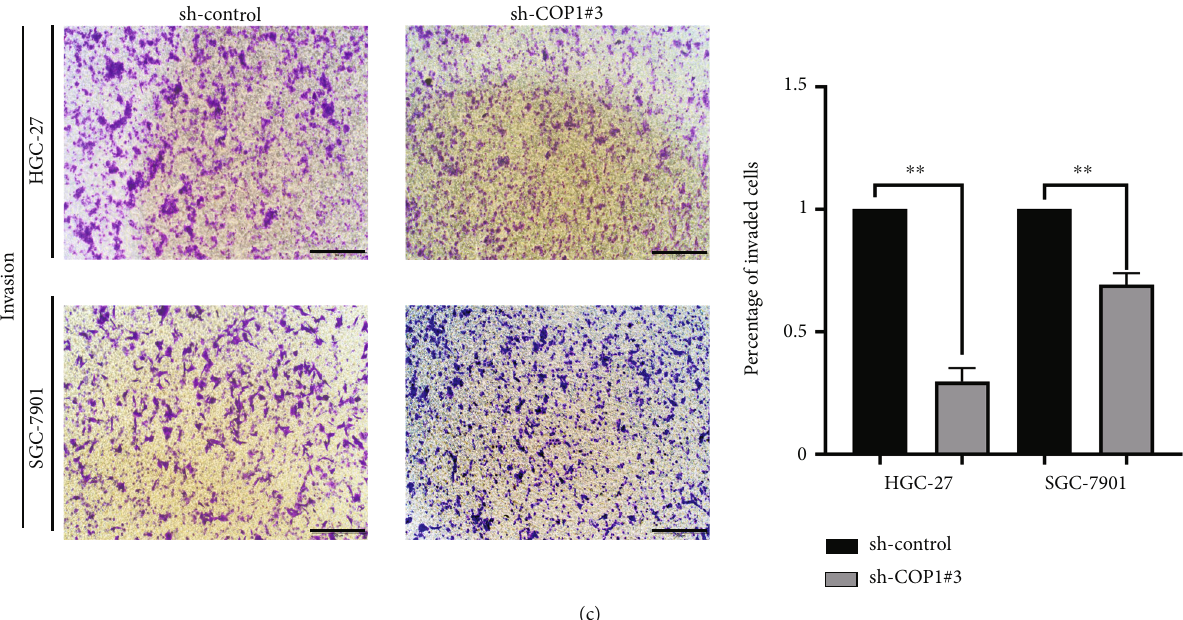
Figure 5: COP1 silencing inhibited the proliferation and migration of GC cells. (a) COP1 silencing inhibited the colon formation numbers of GC cells; (b and c) COP1 silencing signi fi cantly decreased the migration and invasion of GC cells. Bar=200 μ m. * P < 0 : 05 , ** P < 0 : 01 , *** P < 0 : 001